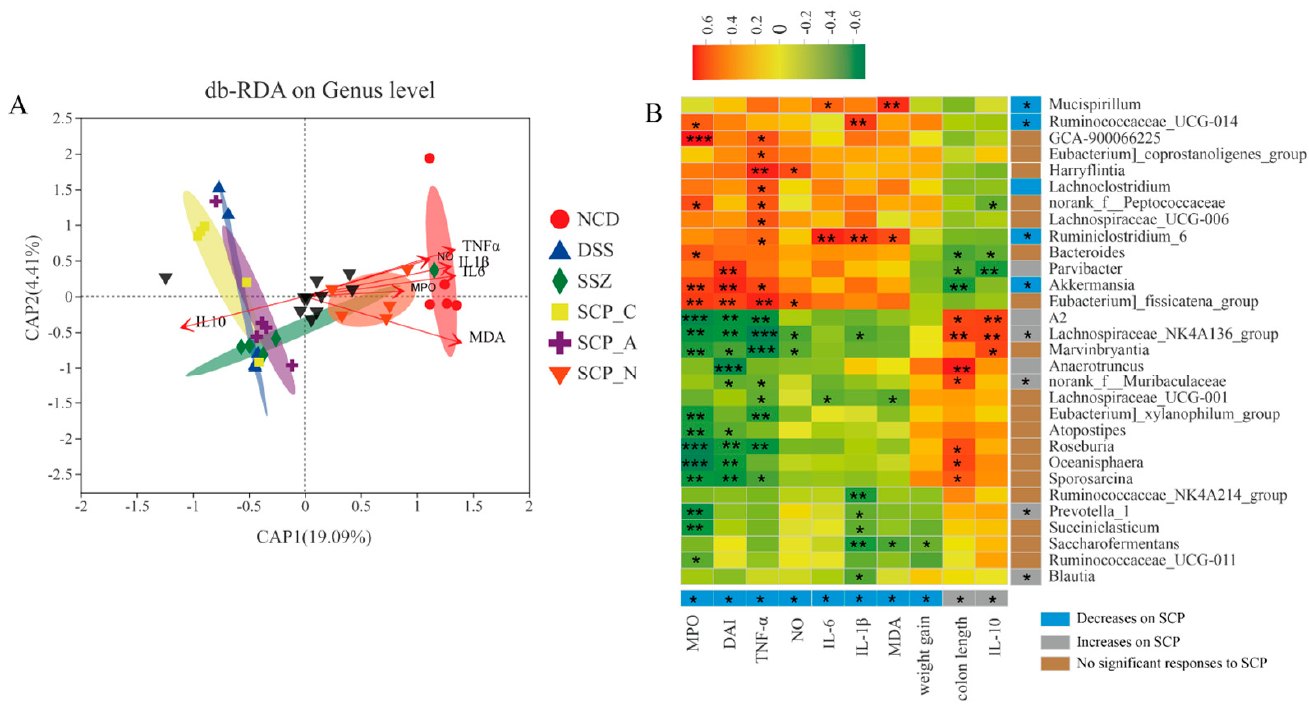
Figure 6. Correlations between UC-related parameters and key phylotypes of microbiota. ( A ) Distance-based Redundancy Analysis (db-RDA) plot showing the relationship between UC- related parameters and gut microbiota structure. The plots represent a db-RDA ordination using the Bray–Curtis distance. The black triangles represent the top ten species. ( B ) Heatmap of the Spearman correlations between the gut microbial composition with UC-related indices. The asterisk (*) denotes statistical significance for the correlations between phenotypes and genus abundance. * 0.01< p ≤ 0.05, ** 0.001 < p ≤ 0.01, *** p ≤